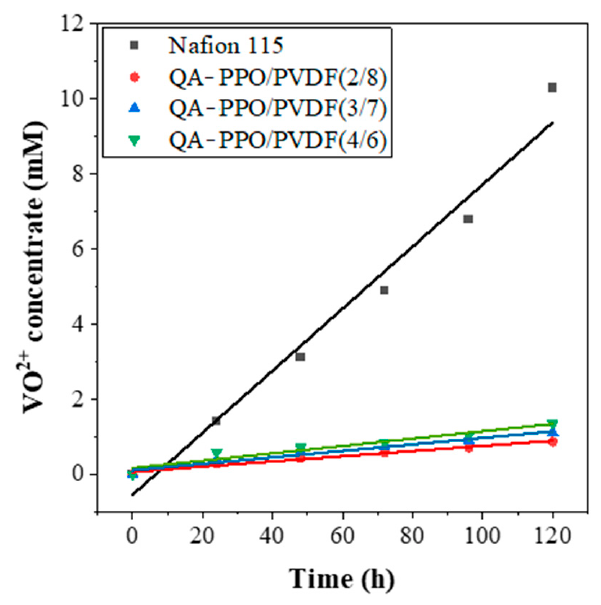
Figure 6. Permeability of VO 2+ ion of the vanadium redox flow battery assembled with BAEMs.